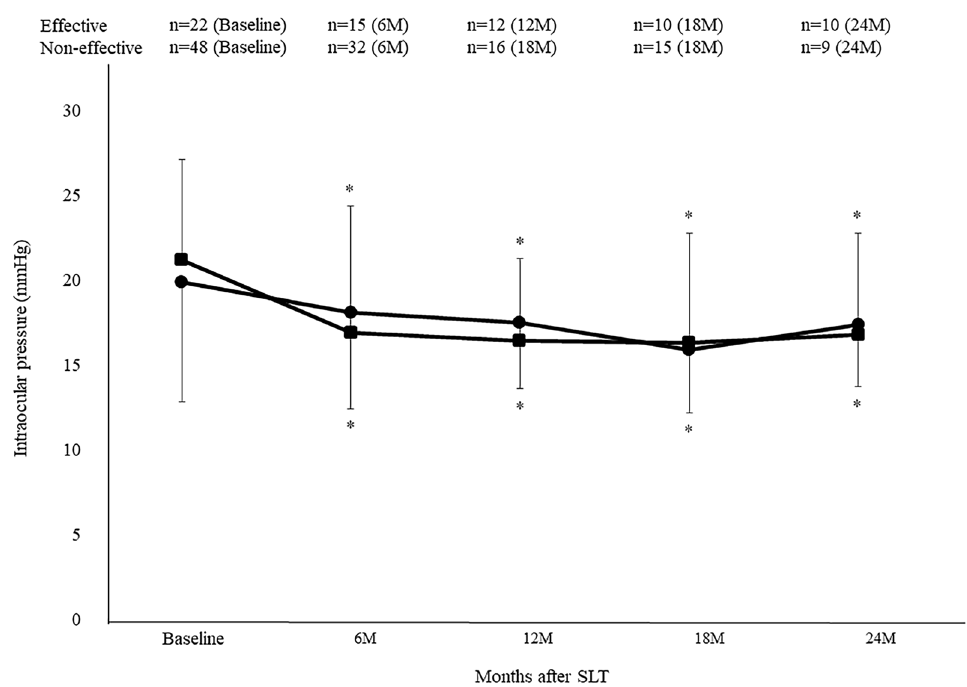
Figure 1. Mean intraocular pressure following selective laser trabeculoplasty in the effective and non-effective groups. Intraocular pressure was significantly reduced in both groups as compared with baseline. * P < 0.05 as compared with